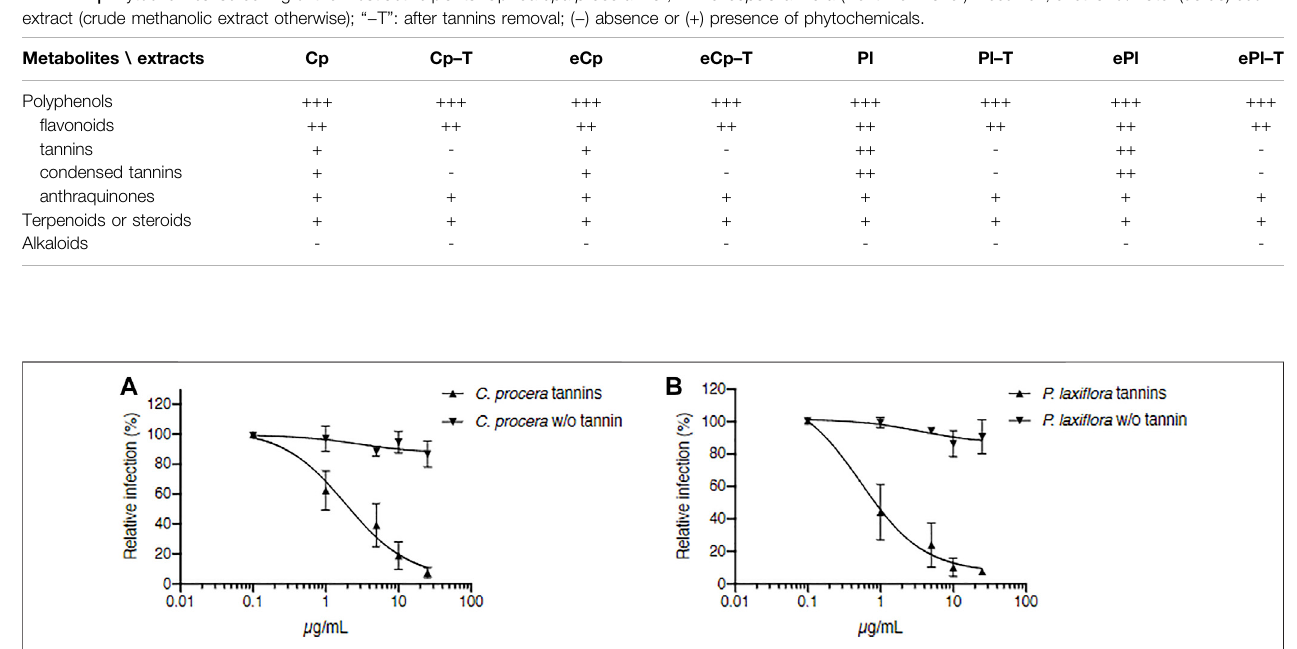
FIGURE 3 | Tannins are responsible for C. procera and P. laxi fl ora activity against HCV. Tannin removal required heating of extracts. C. procera (A) and P. laxi fl ora (B) methanolic extracts were tested on HCV infection after heating (tannins), and after tannins removal (w/o tannins). Quanti fi cation of infection was as described above. Data are presented relative to untreated control and are means ± SEM of 3 experiments performed in